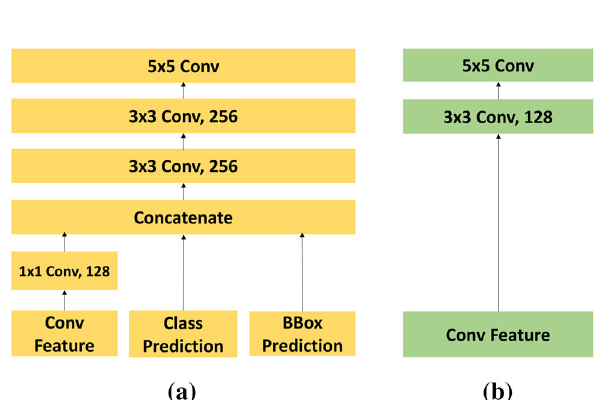
Fig. 4 Recall rate comparison using different NMS methods